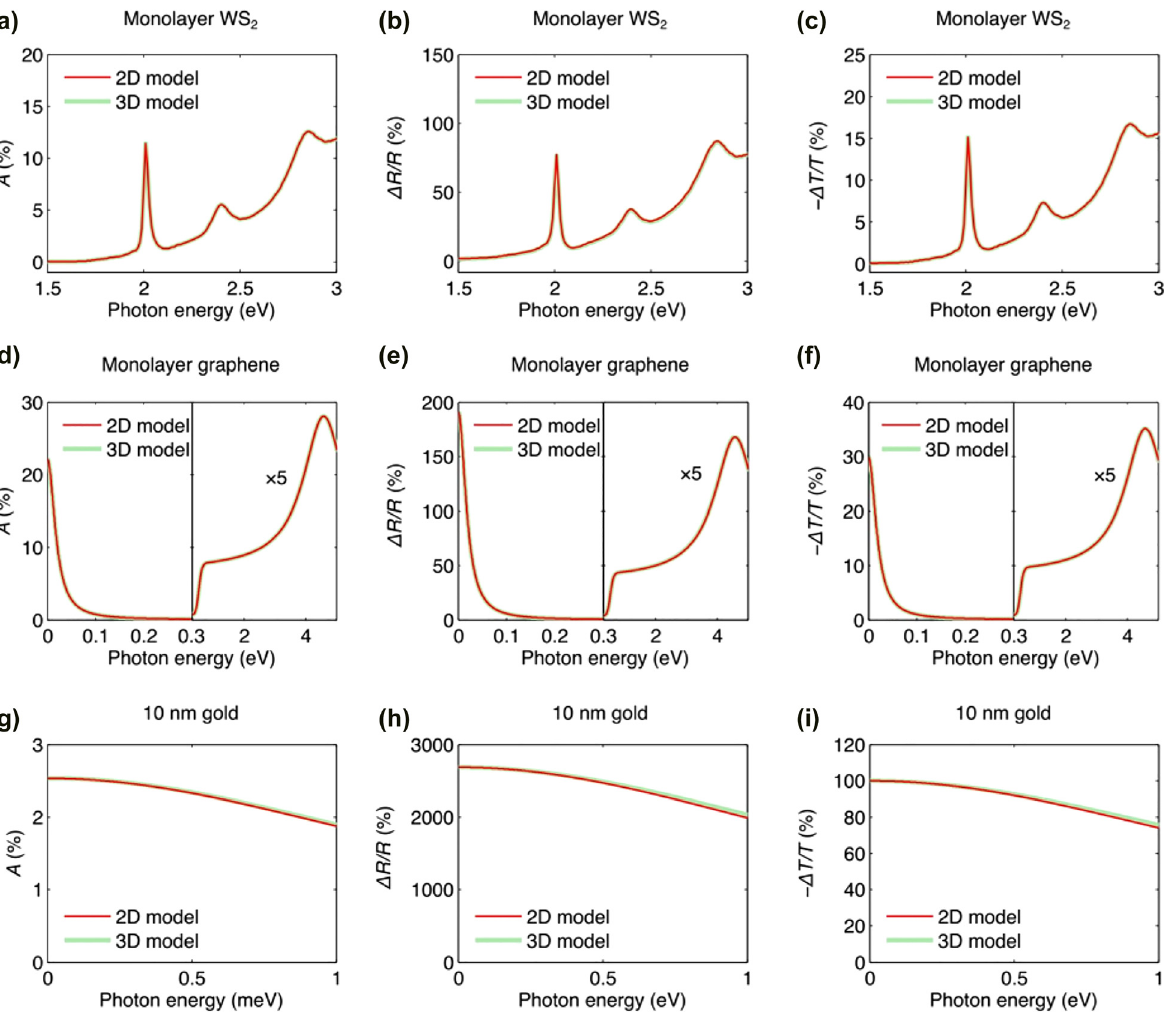
Figure4: Absorption( A ), re fl ectioncontrast( Δ R / R ),andtransmissioncontrast( Δ T / T )of (a – c)monolayerWS 2 ,(d – f)graphene,and(g – i) 10nm gold fi lm on fused silica substrates. Reprinted with permission from Ref. [13], copyright 2018, IOP